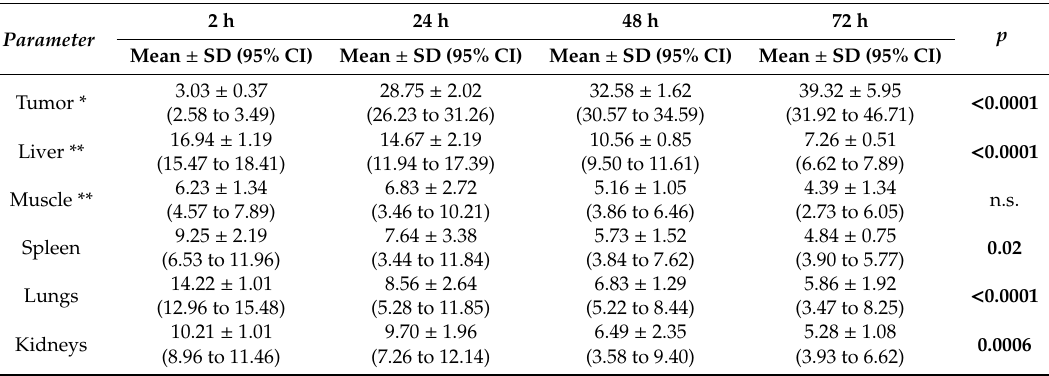
Table 2. Ex vivo fluorescence (NET / Area) of organs at di ff erent time points.